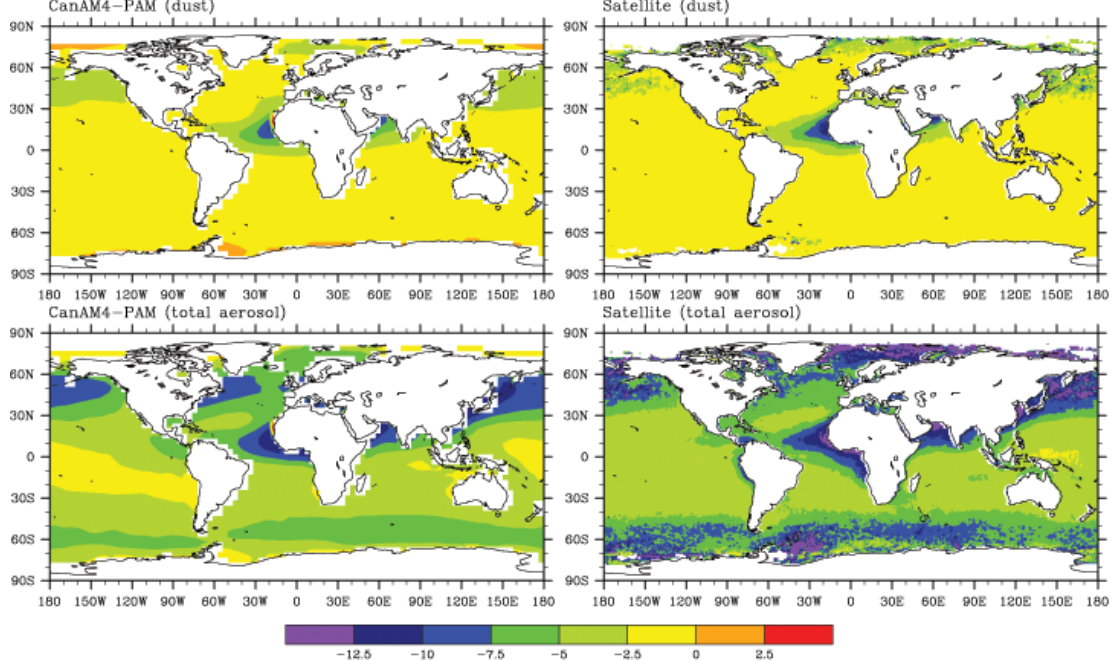
Fig. 17. ADRF comparison between satellite measurements and CanAM4-PAM results for dust and total aerosols over the ocean. Unit is Wm − 2 . Data are for year